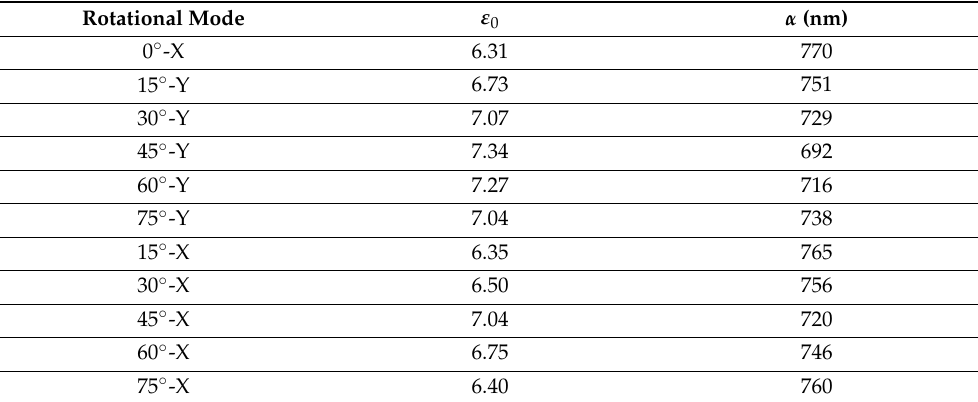
Table 3. Wavelength of absorption edge and static dielectric constants of FAPbBr 3 perovskite for all rotational modes.